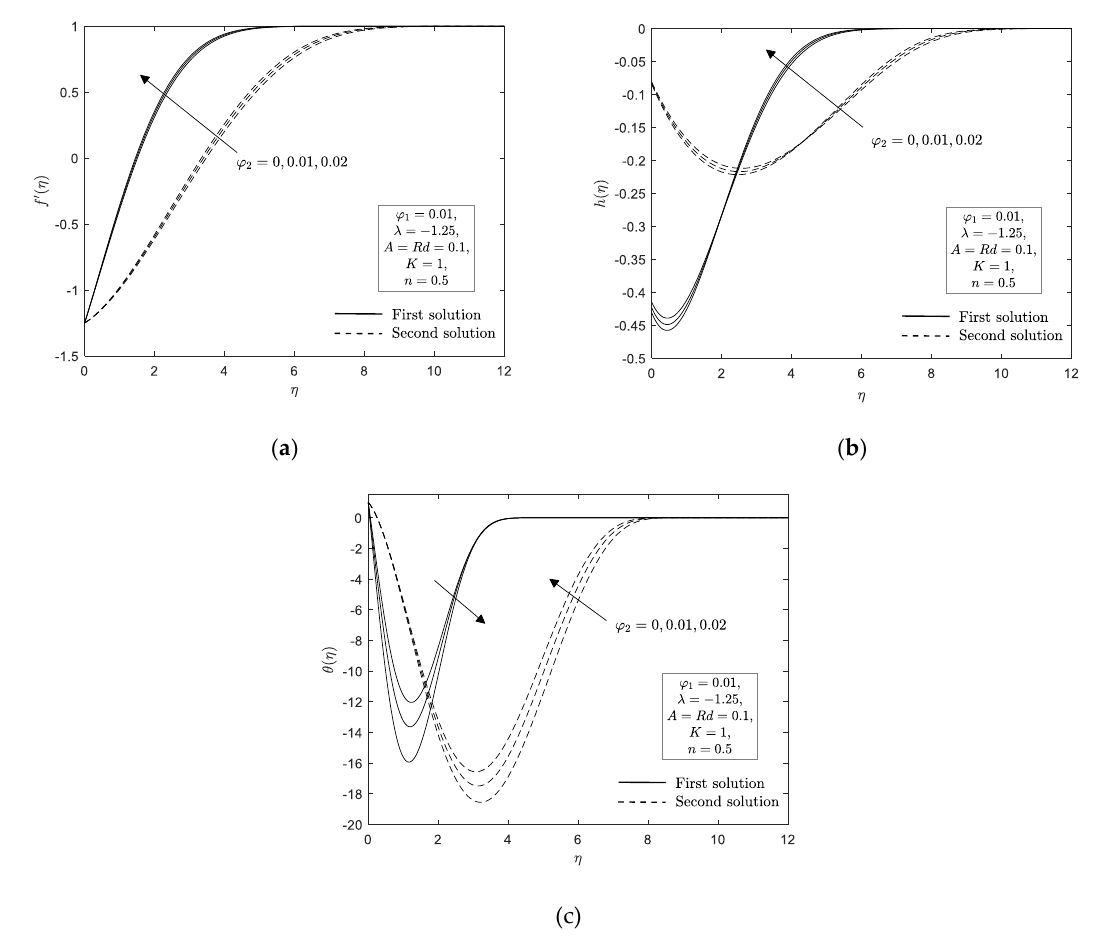
 . Figure 2. ( a ) C f Re 2